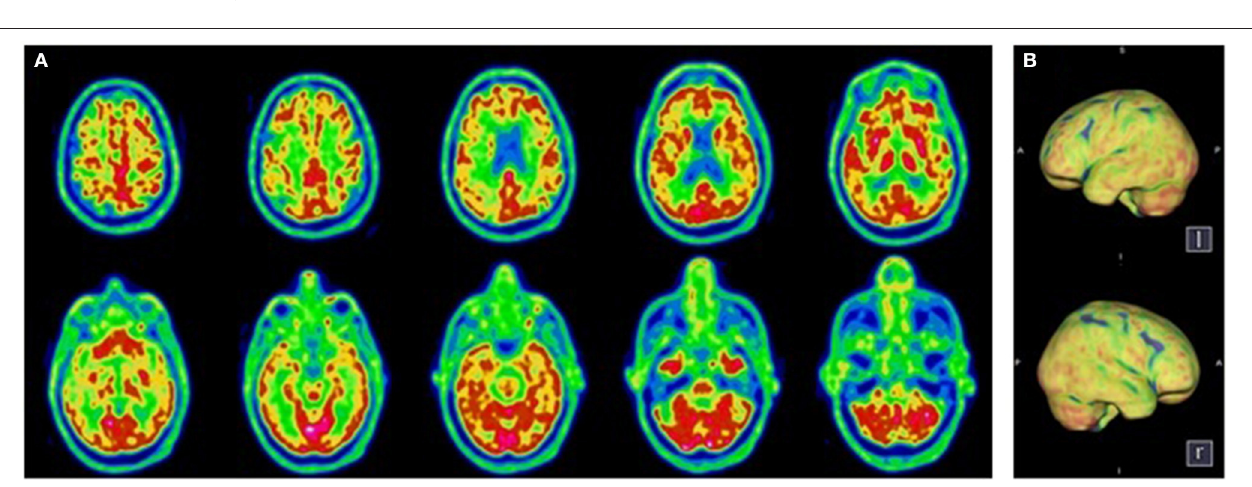
FIGURE 1 | Transaxial (A) and Volume Rendered Brain (B) 18 F-FDG PET. Diffuse cortical hypometabolism. Normal metabolism of the sub-cortical structures and the